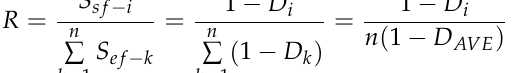
Initial damage state; ( b ) damaged state after under 6.5 × 10 3 loads; ( c ) damaged state after under 1.3